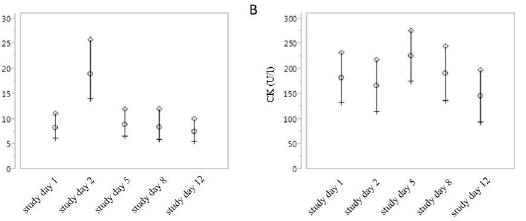
Fig 4. Training procedures only causes alterations in cfDNA and not in CK levels. Kinetics of cfDNA (A) and CK concentrations (B) duringthe 4 week intervention.Mean (circles) and 95% upper (diamonds) and lower (crosses) values are